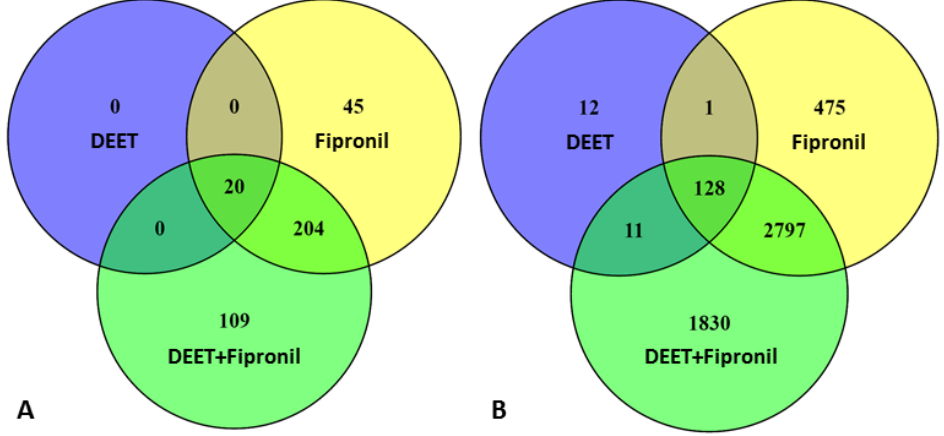
Figure 1. Relationships between the number of long non-protein coding RNAs (lncRNAs) whose transcripts were significantly ( p ≤ 0.01 ) differentially up- and downregulated ( A ) and protein-coding genes whose transcripts were significantly ( p ≤ 0.01 ) differentially expressed ( B ) when primary human hepatocytes were treated with DEET (100 µM), fipronil (10 µM), or a mixture of the two (100 µM DEET and 10 µM fipronil) for 72 h.